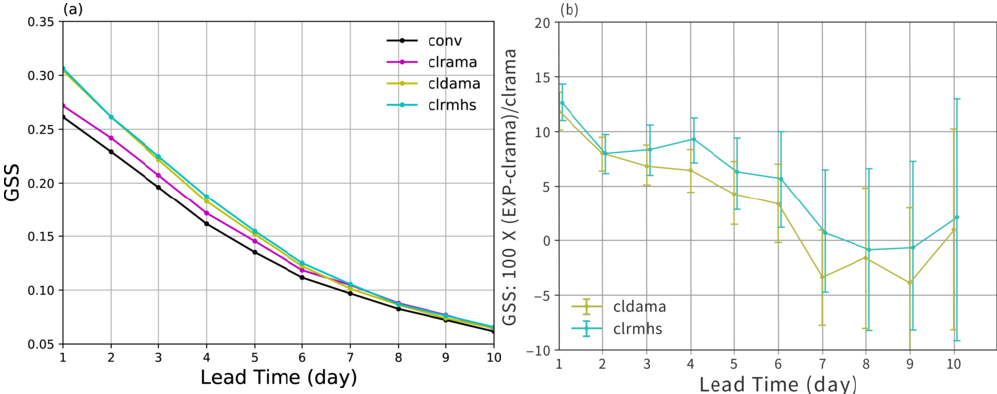
Figure 13. (a) Gilbert skill scores (GSSs) of 24h accumulated precipitation forecast verified against CMORPH observations for a threshold of 10mm. (b) Relative difference of GSSs between cldama / clrmhs and clrama , also for a threshold of 10mm.